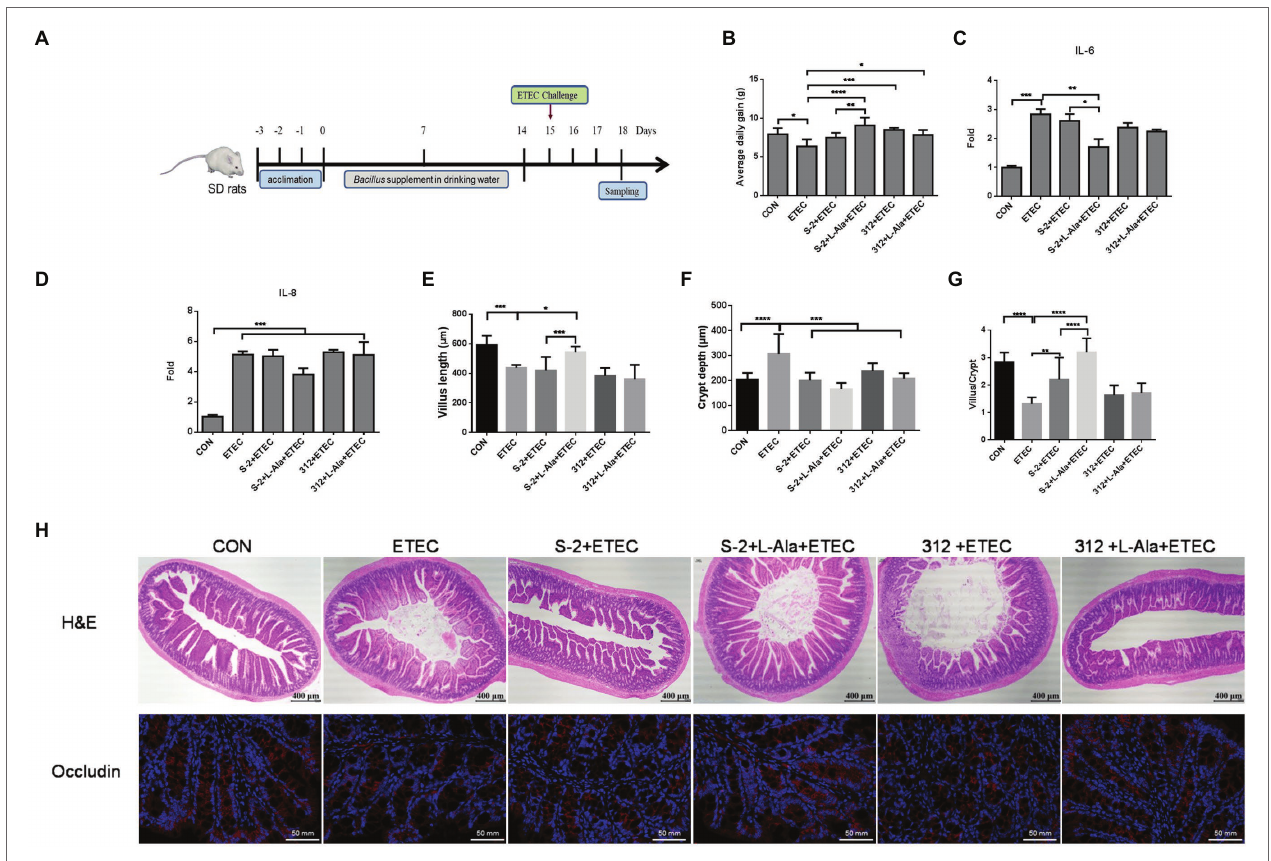
FIGURE 6 | Promoting effects of L-alanine-mediated spore germination on animal growth and intestinal barrier. (A) Diagram illustrating the ETEC-challenge model employed in this study. (B) Average daily gain of SD rats feeding B. subtilis S-2 and 312 spores with or without L-alanine treated from day 15 to day 18. (C,D) The mRNA fold of IL-6 and IL-8 in the jejunum of SD rats feeding different spores. (H) H&E stain (up line) and immunofluorescence analysis (IFA; bottom) of occludin in the jejunum of SD rats. Occludin was stained as red, and DAPI was stained as blue. (E–G) The villus length, crypt depth, and villus length/crypt depth ratio in jejunum of different groups, respectively. Values are expressed as the mean ± SD from at least 6 animals. * p < 0.05; ** p < 0.01; *** p < 0.001; **** p < 0.0001, as calculated by one-way ANOVA with Tukey’s multiple comparisons test. Groups without significant difference were not